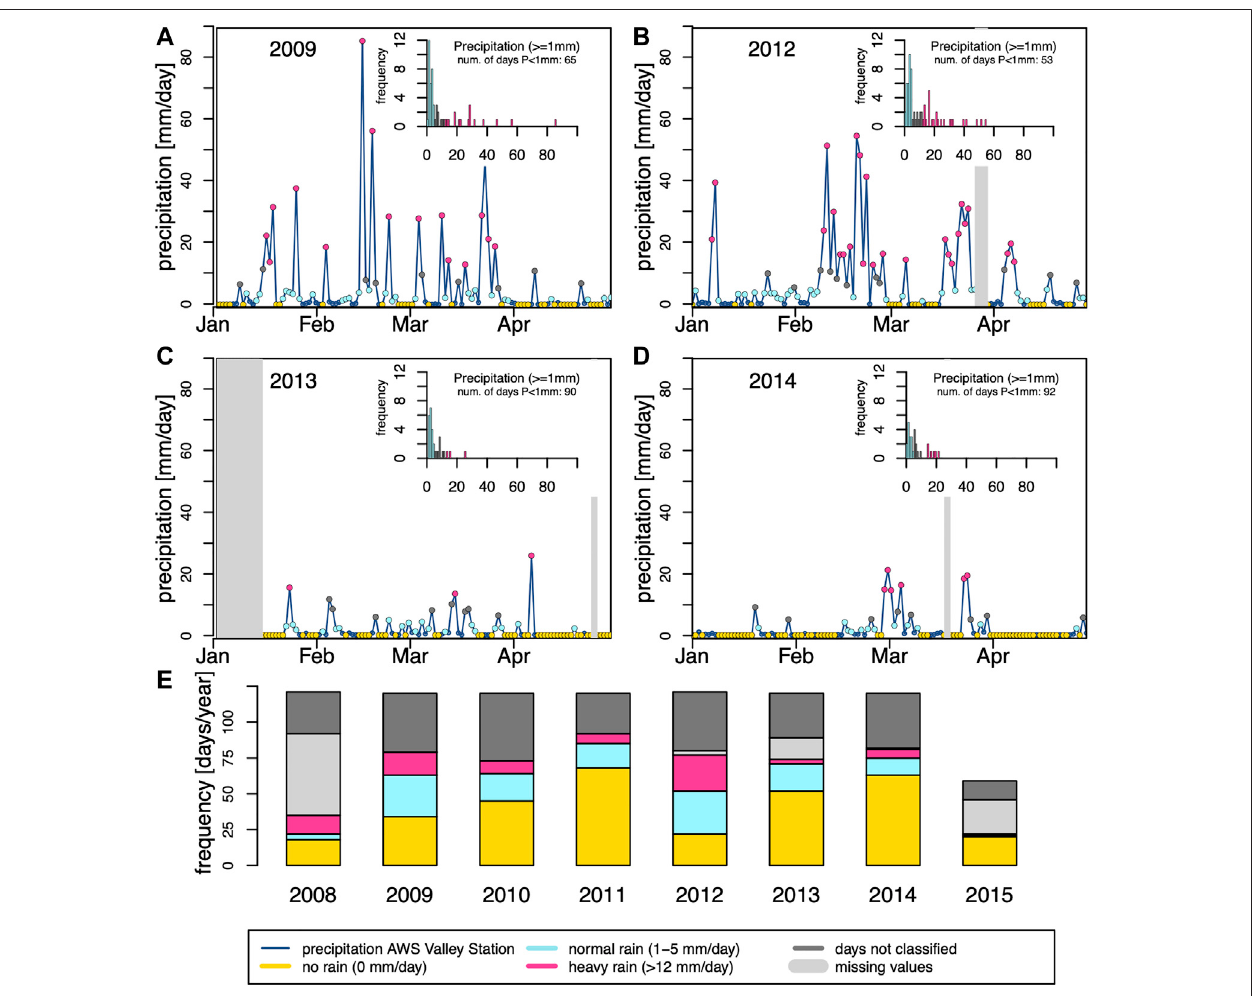
FIGURE3| DailyprecipitationoftheValleyStationduringtherainyseasonsoftheyears2009 (A) ,2012 (B) ,2013 (C) and2014 (D) anditsfrequencydistributionof all respective precipitation values above or equal 1 mm. The stacked barplot at the bottom (E) shows the year-to-year variability of the frequency of days regarding rain amount, not classi fi ed and missing values. The colors, irrespective of bars or dots, show the classes “ no rain ” , “ normal rain ” and “ heavy rain. ”